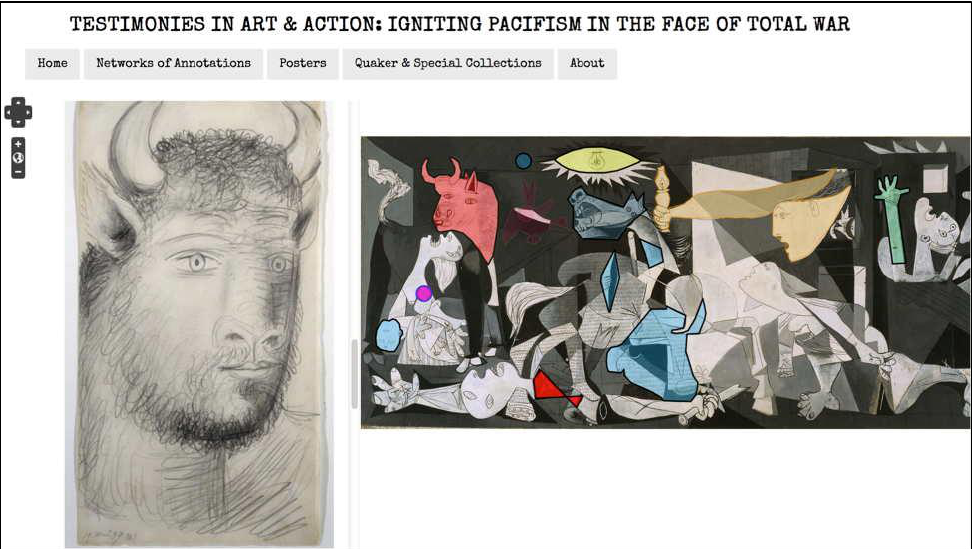
FIGURE 1: MADISON ARNOLD-SCERBO USES STAGES OF THE BULL TO ESTABLISH HER READING OF